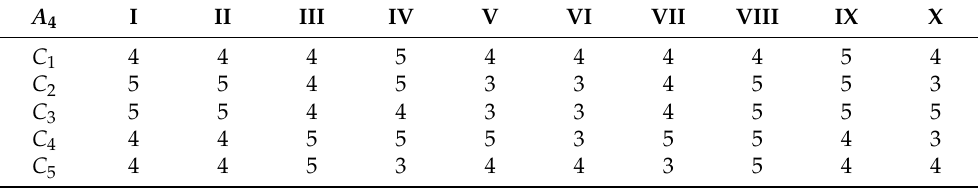
Table 5. Ratings of alternative A 4 in relation to the evaluation criteria obtained from 10 respondents.